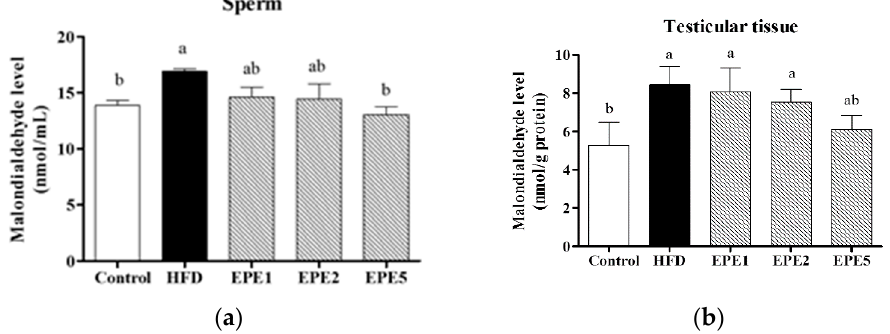
Figure 5. Effects of Echinacea purpurea ethanol extract on Malondialdehyde (MDA) production in ( a ) sperm and ( b ) testic- ular tissues of HFD-induced obese rats after 5 weeks. Data are shown as the mean ± S.E.M. (n = 5). The values with different superscript letters ( a , b ) are significantly different ( p < 0.05), determined via one-way ANOVA, and were analyzed by Duncan’s multiple range